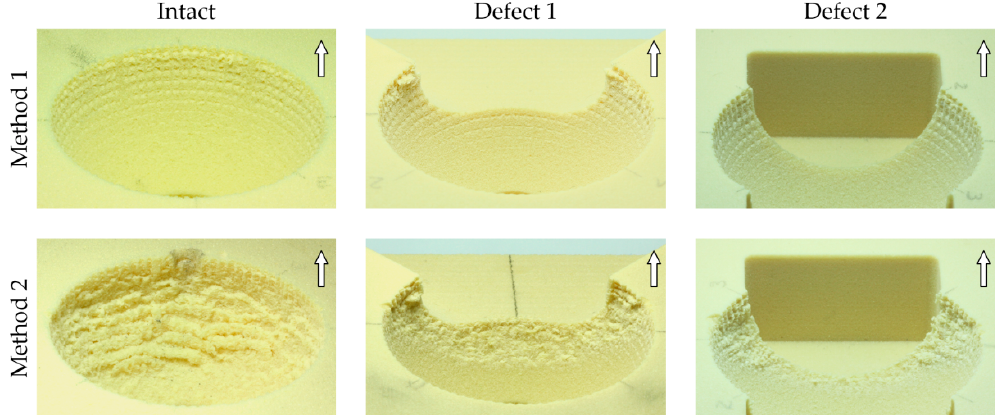
Figure 8. A visual comparison of the cavity surfaces after disassembling the acetabular cups from the PU foam cavities (30 pcf) with Method 1 and Method 2. The arrows in the upper right corner of the figures represent the direction of acetabular cup tilting (superior). In all the cavities tested with Method 1, clear impressions of the barb-like surface structure of the acetabular cup, caused by cup insertion, were present. The small areas where shear stress was detected were located in the direction of acetabular cup tilting (superior). In the acetabular cups tested with Method 2, extensive abrasion of the foam structure was present in the direction of acetabular cup tilting, indicating the occurrence of higher shear stress in the implant–bone interface.